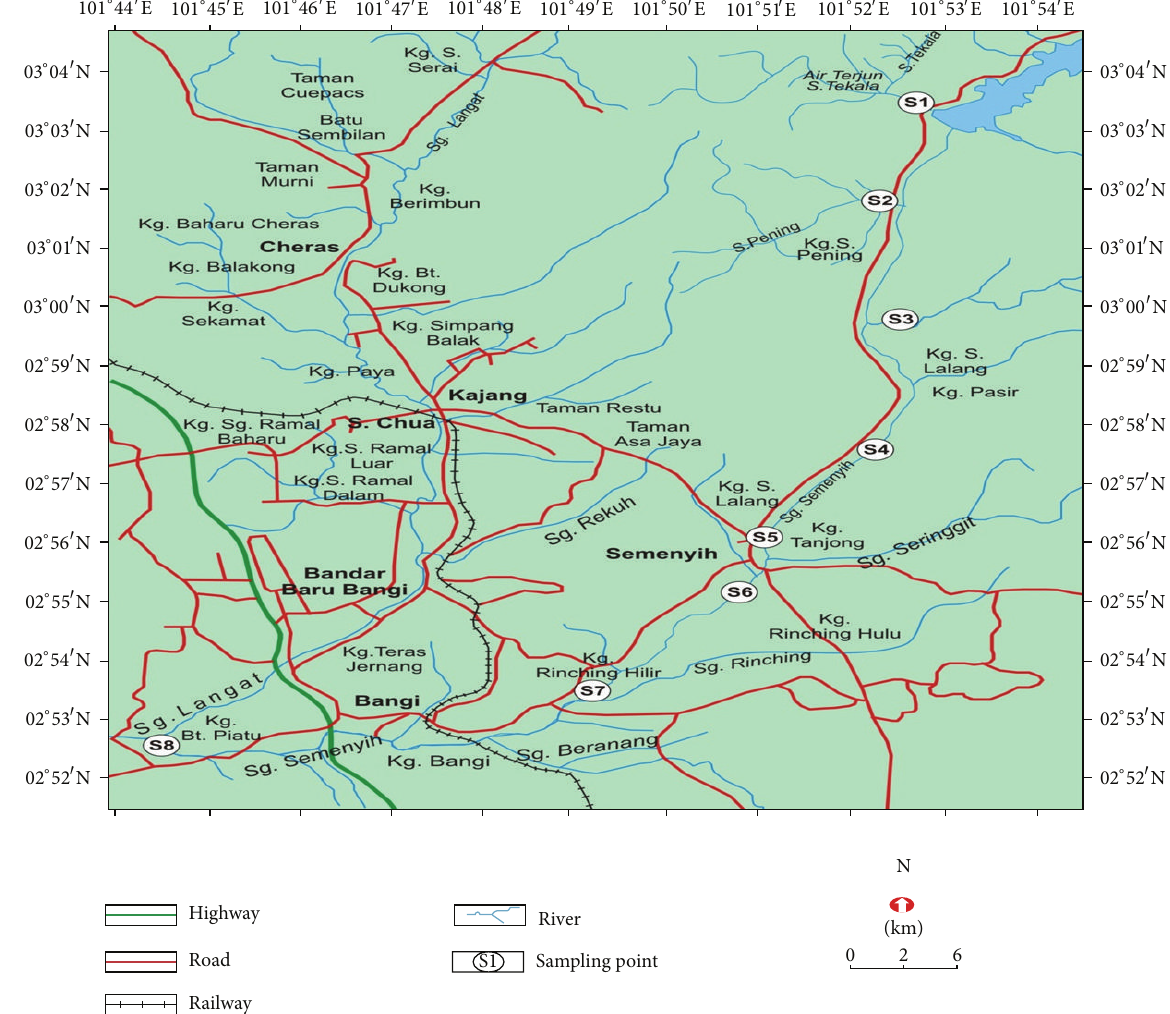
Figure 1: Study area and sampling stations along the Semenyih